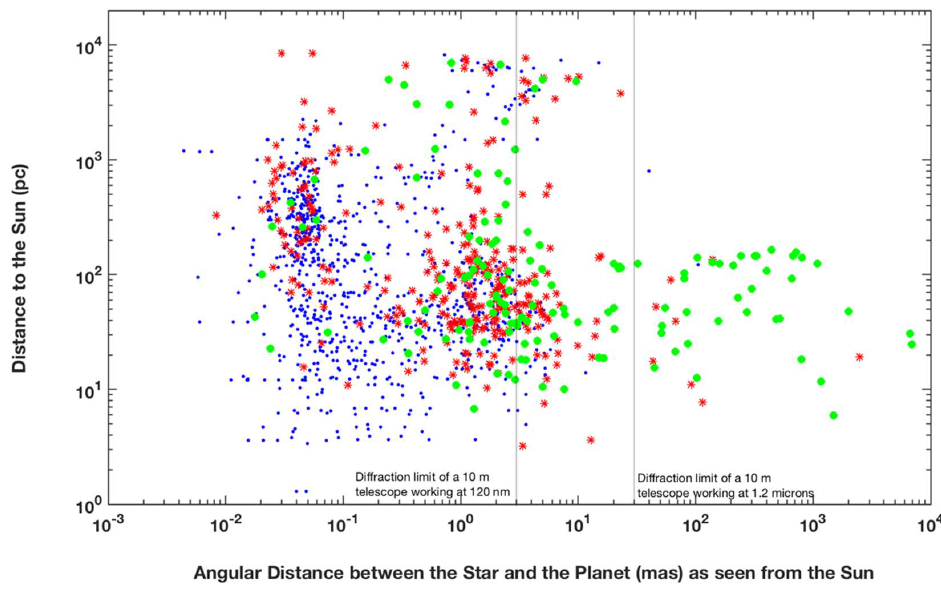
Figure 2. Parameters of known exoplanetary systems: distance to the Sun versus angular distance between the planet and the parent star. Masses of planets are color coded: M p ≤ 2M E (blue dots), 2M E < M p < 10M E (red asterisks), M p ≥ 10M E (green circles). Data from exoplanets.eu/catalog. An additional challenge results from a planet’s luminosity; planets are intrinsically faint objects.